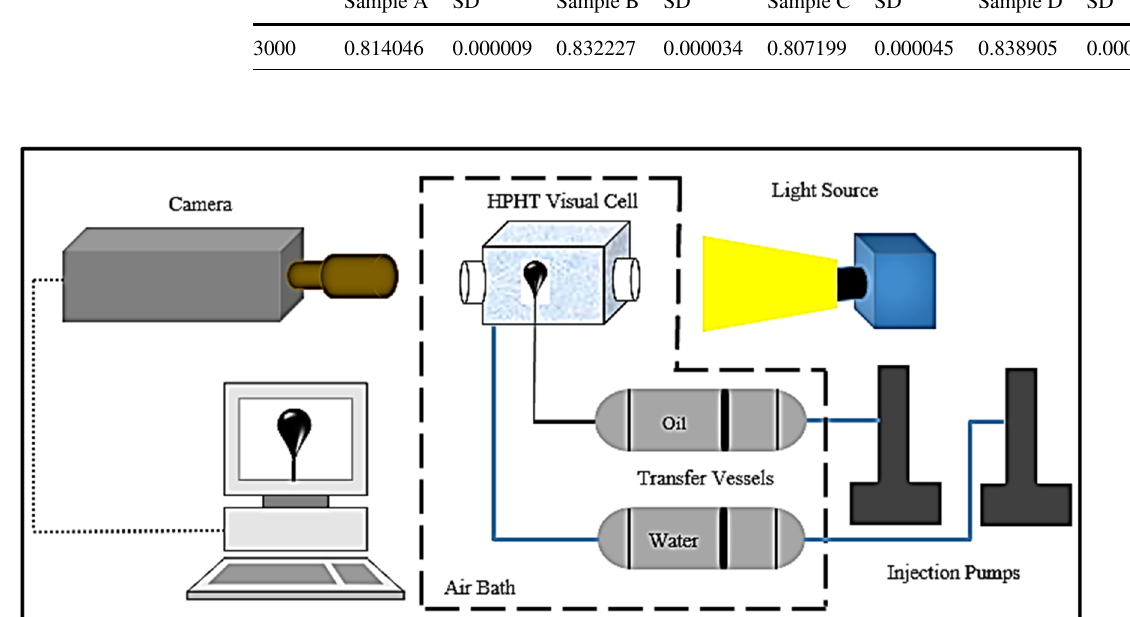
Fig. 2 Schematic of captive drop